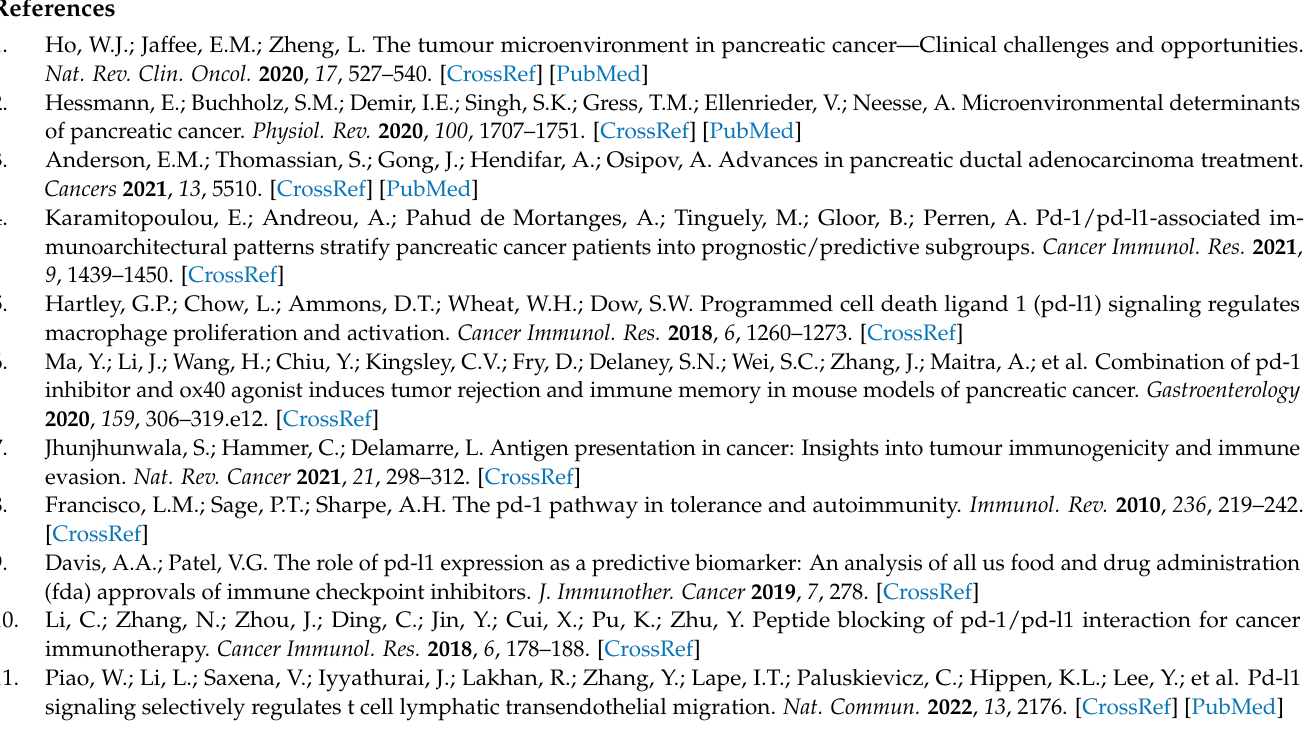
densities. Figure S3: The proportion of PD-L1 + tumor cells (PD-L1 + PanCK/SOX10 + ) was unrelated to the proportion of PD-1 + CD8 + cells in the CD8 + subset. Table S1: Clinical sample information. Table S2: The patients’ basic